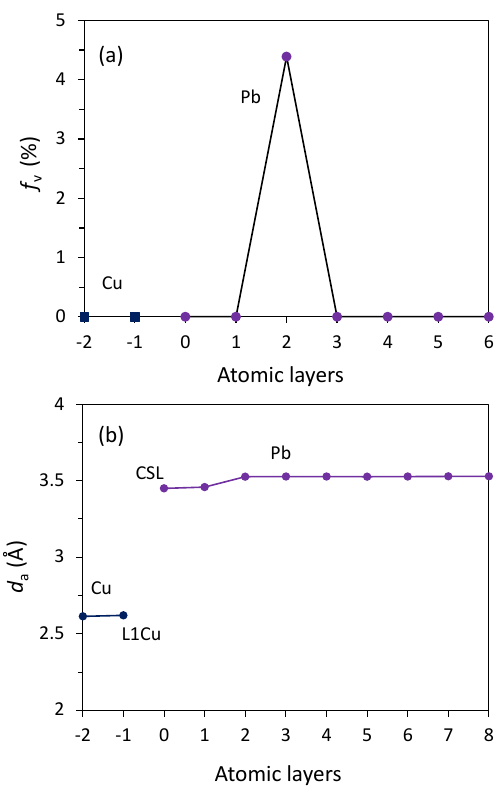
Figure 9. The ( a ) vacancy concentration, f v , and ( b ) average in-plane atomic spacing, d a , of the indi-vidual Pb layers at the interface as a function of the distance, z , from the interface for the Pb( l )/Cu( s ) system at T n = 594 K and t = 1000 ps.